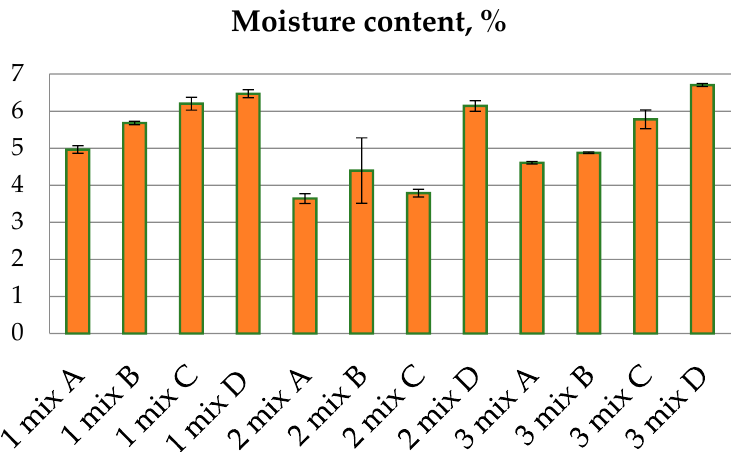
Figure 2. Moisture content of pellets, % (proportions of potato and beans: 1:1 (A); 1:2 (B); 1:3 (C); 1:4 (D) by volume).